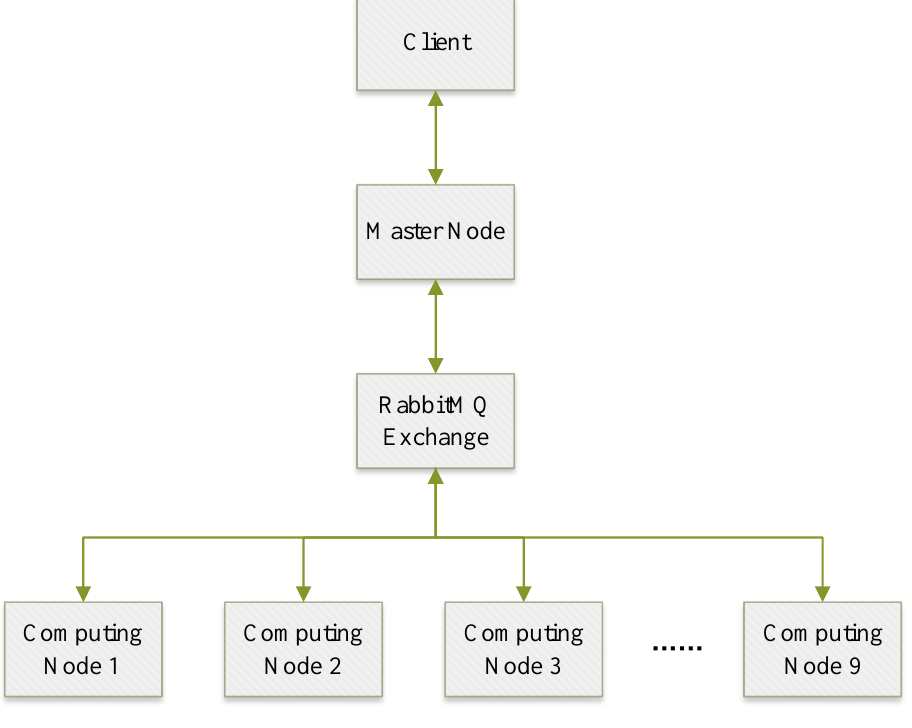
Figure 6. System architecture.